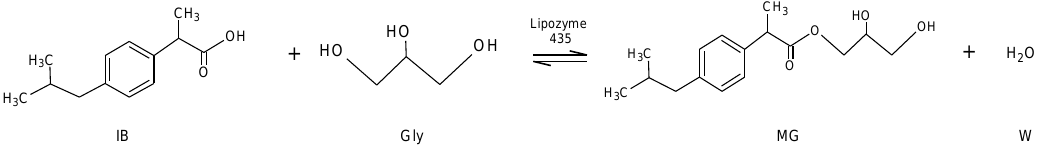
the enzyme concentration for further runs.